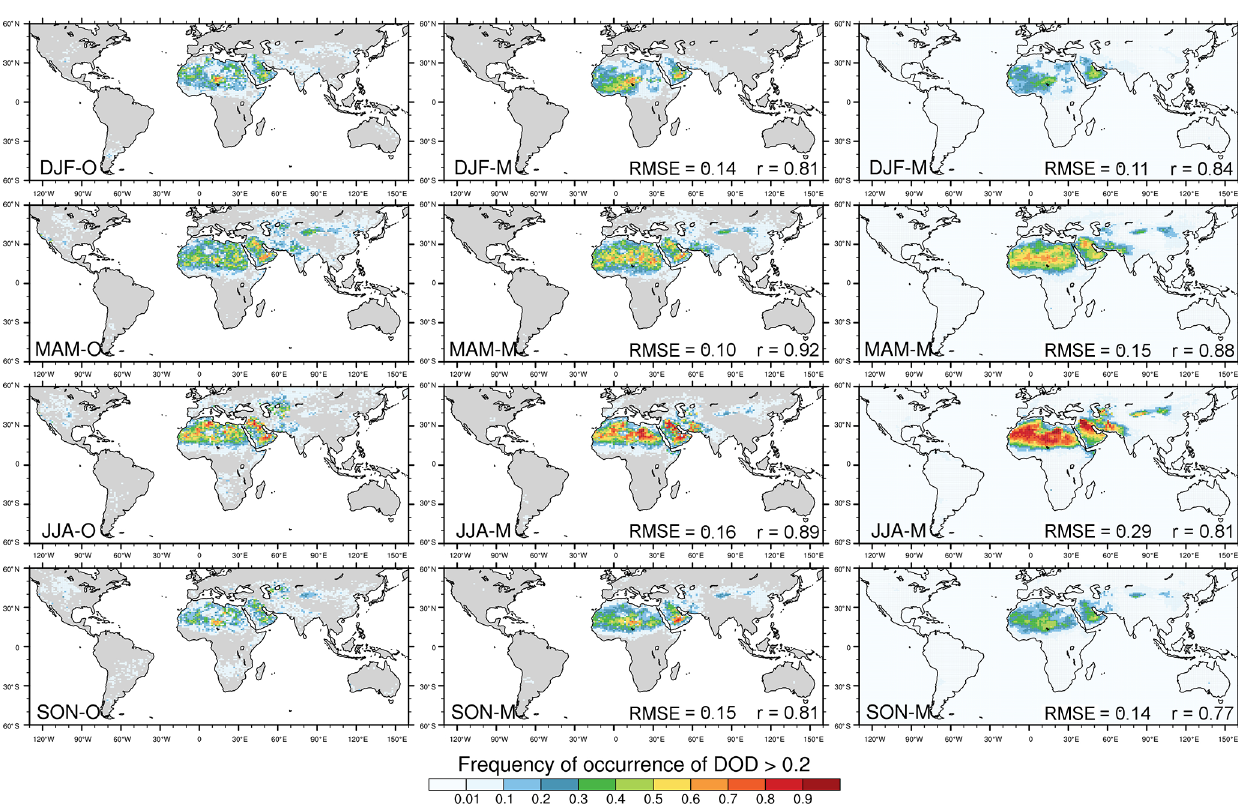
Figure 6. Seasonally averaged FoO of DOD > 0 . 2, normalized by the number of days per season for MODIS Deep Blue (left), MONARCH all-sky DOD coarse at satellite overpass time co-located with MODIS DOD (middle), and MONARCH clear-sky DOD coarse at approximated satellite overpass times derived from 3-hourly model output (right). The FoO was calculated with respect to the number of days in the season. Area-weighted RMSE and uncentered Pearson product-moment coefficient of linear correlation (r) are indicated in the respective